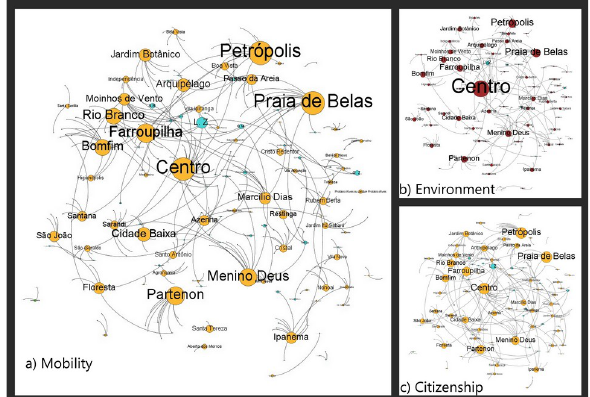
Figure 5. Networks for Mobility(a), Environment (b) and Citizenship